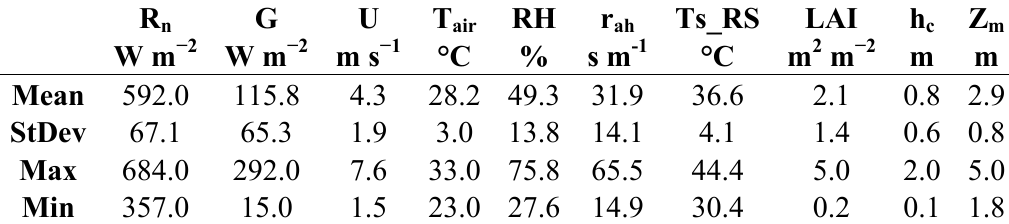
Table 1. Summary of available